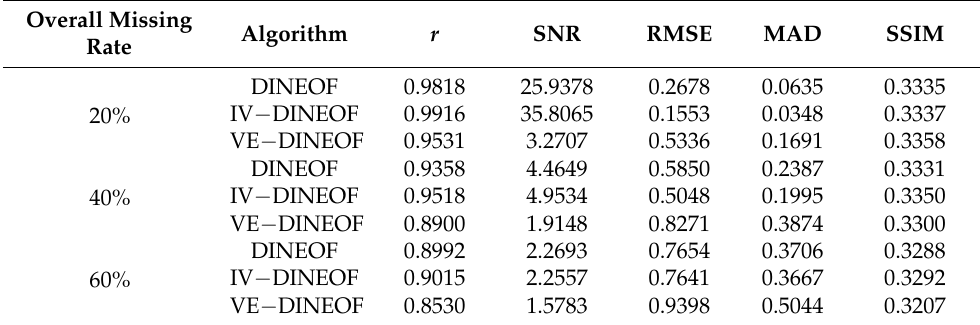
Table 2. Comparison of verification metrics among DINEOF, IV − DINEOF, and VE − DINEOF for different overall missing rates in Dataset1.